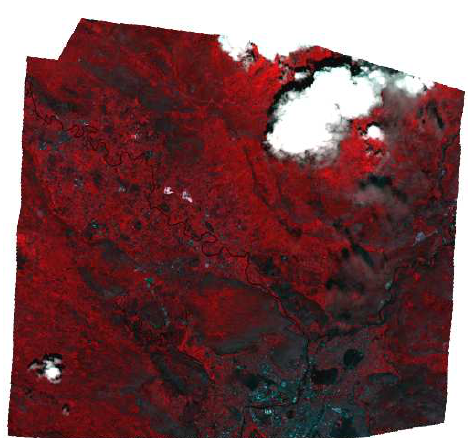
Figure 8. The Podgorica data of size 11948 × 11007 pixels represented in a false color composition: (Near infrered, Red and Green) as